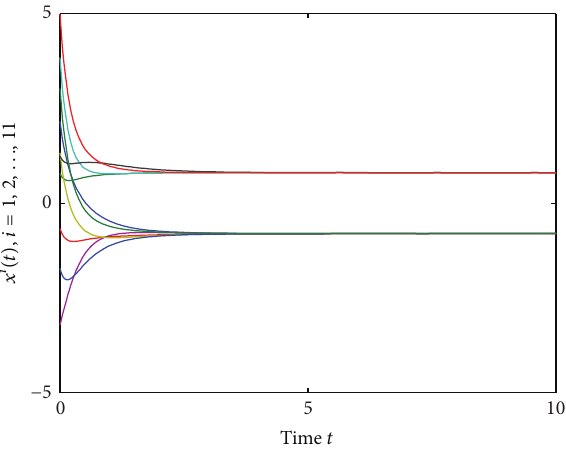
Figure 3: The time histories of 𝑥 𝑖 (𝑡) , 𝑖 = 1, 2, .. ., 11